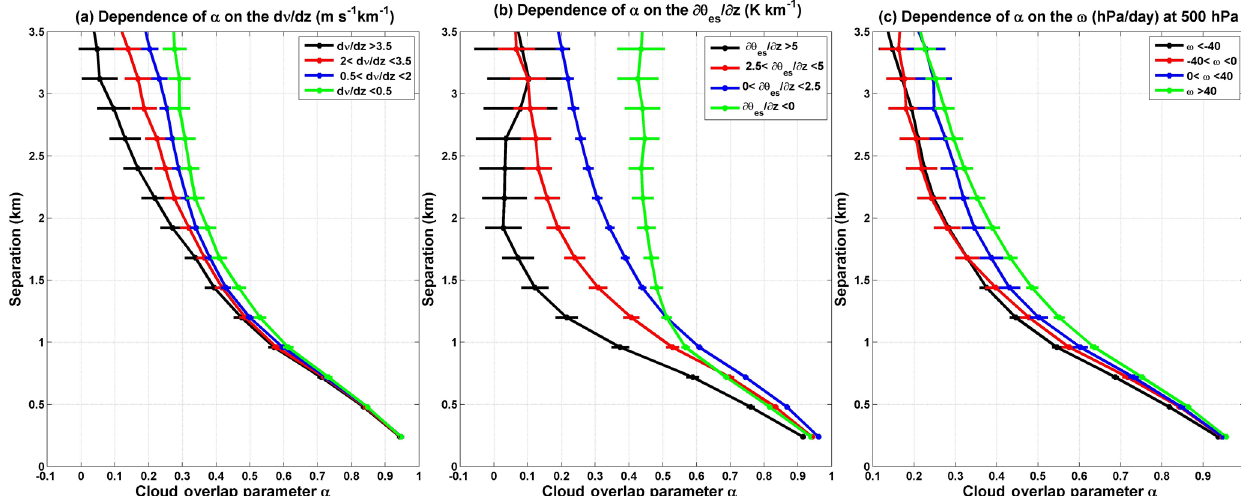
Figure 5. The sensitivities of median overlap parameter α to the (a) wind shear, (b) instability, and (c) vertical velocity at 500hPa at a given upper limit of cloud cover (50%) and spatial scale (50km) for the contiguous cloud layers. The horizontal bars correspond to means ± 3 standard errors, which represent the upper and lower endpoints of the 99% confidence